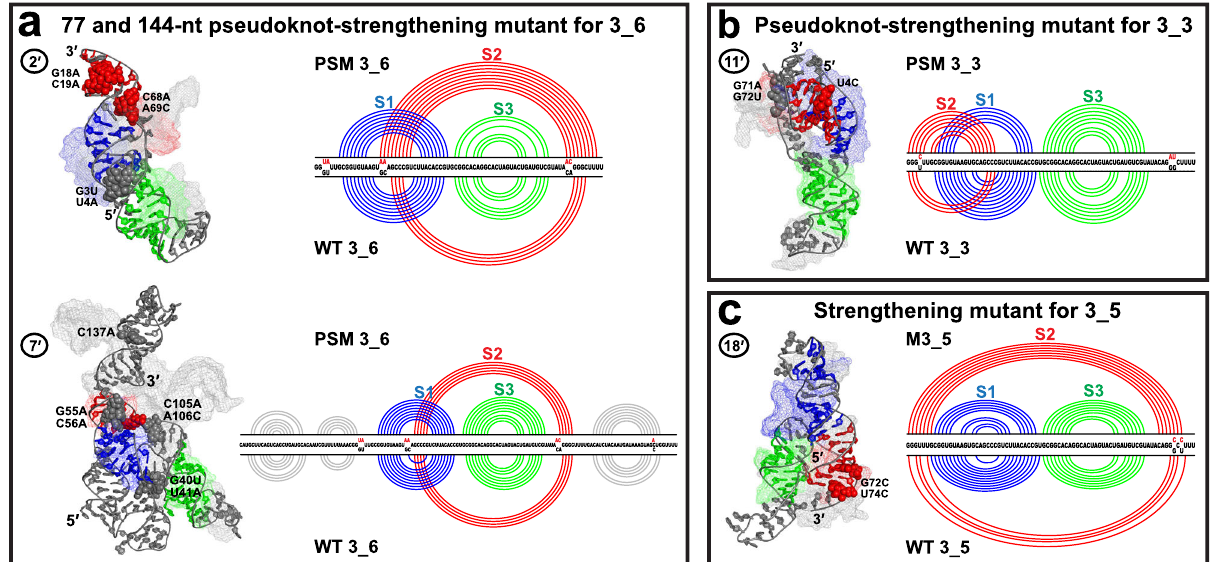
Fig. 7 Comparison of the motif-strengthening mutants with the wildtype systems. a For the 3_6 pseudoknot, both the 77-nt and 144-nt PSM are shown in cartoon mode with their wildtype systems aligned in mesh (by PyMol 77 for the 77-nt region). The mutations are highlighted as spheres in pseudoknot-strengthening mutant (PSM) structure and labeled. The 2D structure comparison is also provided with PSM at top and wildtype at bottom. Comparisons for the ( b ) 77-nt 3_3 PSM and ( c ) 77-nt 3_5 mutant are shown in similar manner. Systems are numbered according to Table